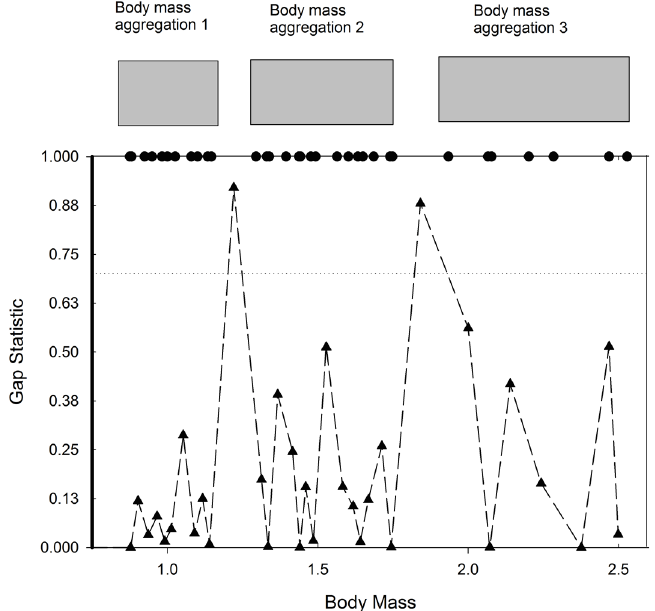
Figure 1. Body mass structure of the Oahu introduced bird community. The upper axis shows the location (black circles) of successfully introduced bird species along a log body mass axis. Gray rectangles represent the three identified body mass aggregations. Gap Statistic is a measure of the deviation of the observed body mass distribution from the unimodal null